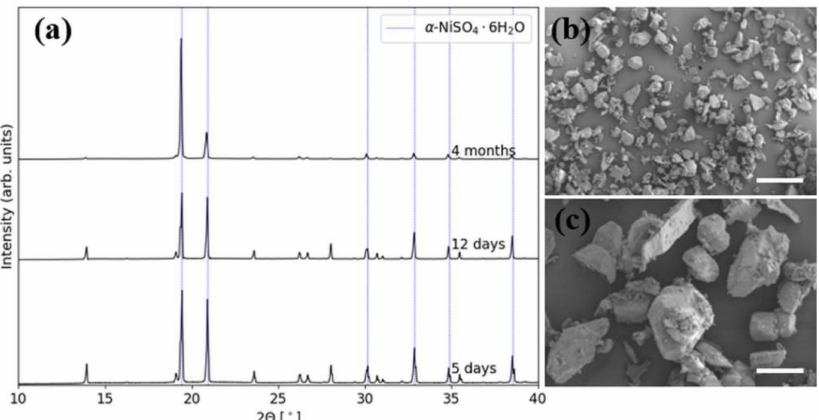
Figure 3. ( a ) XRD spectra of phase pure α -NiSO 4 · 6H 2 O seeds, synthesized by evaporative crystalliza- tion at 40 ◦ C. Spectra shows pure α -NSH at all times, with blue lines indicating the most prominent characteristic peaks. Changes in the relative intensities of the peaks were interpreted as a result of crystal alignment. ( b , c ) SEM micrographs of the seeds are shown at various magnifications. Scale bar: ( b ) 400 µ m, ( c ) 100 µ